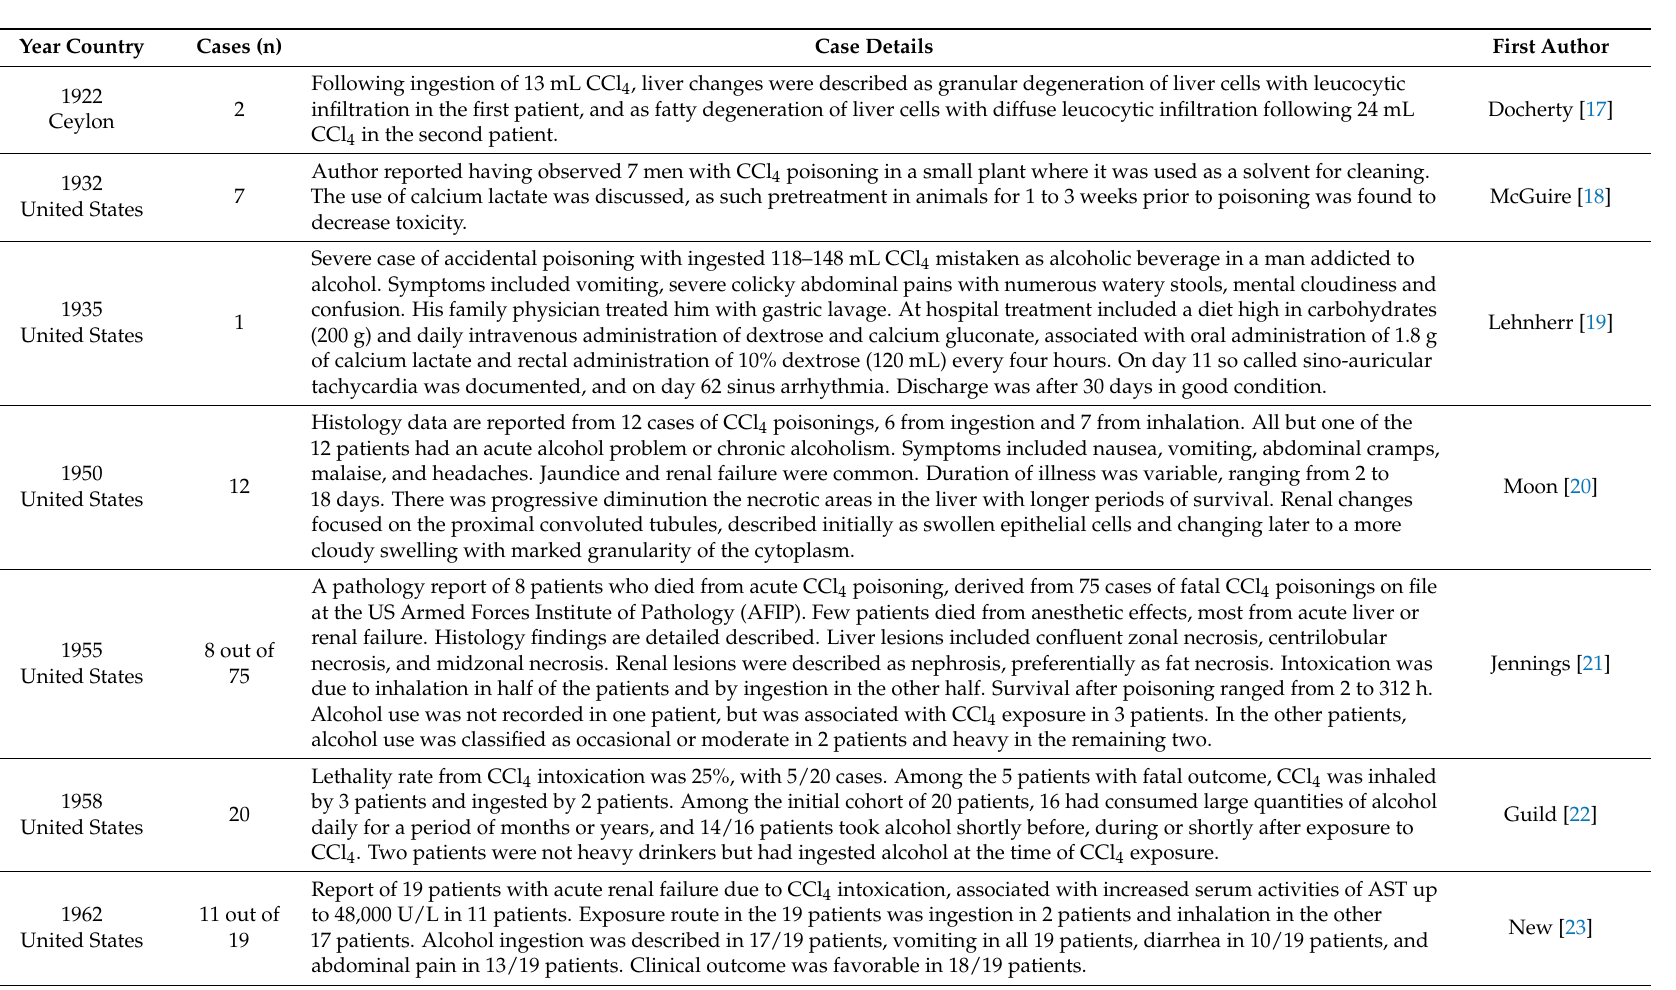
Table 1. Selection of historical cases of liver injury by acute CCl 4